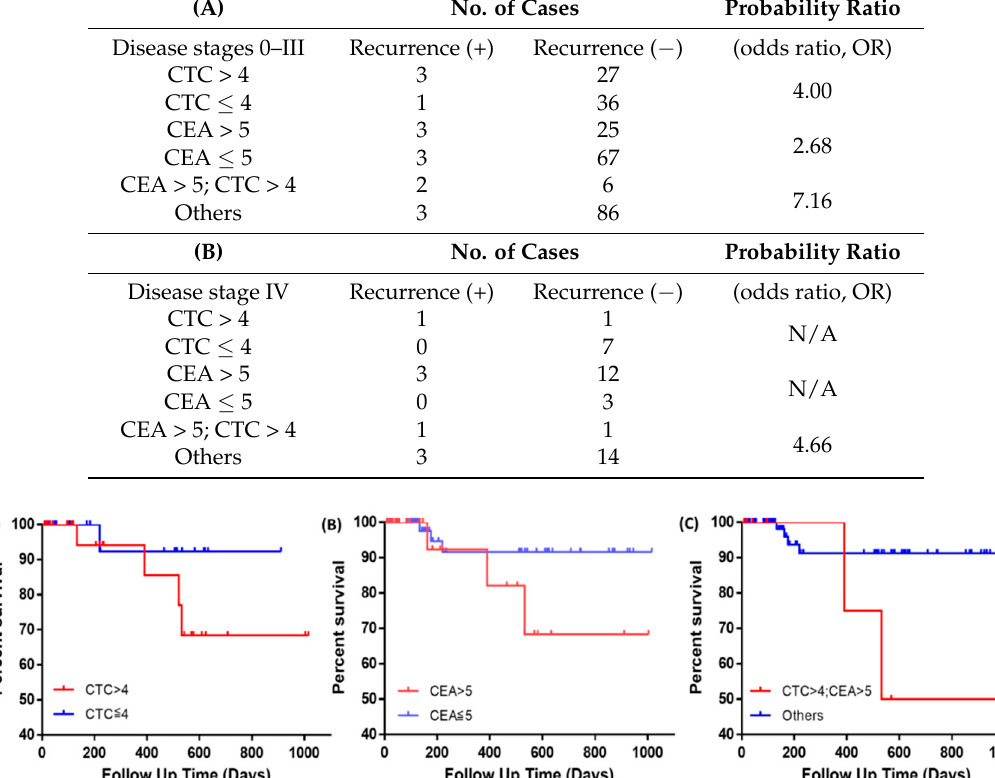
Figure 5. Kaplan–Meier survival curves of progression-free survival in patients with non-metastatic diseases, stratified with CTC and CEA. ( A ) Red line: CTC > 4; blue line: CTC ≤ 4; p = 0.242; ( B ) red diseases, stratified with CTC and CEA. ( A ) Red line: CTC >4; blue line: CTC ≤ 4; p = 0.242; ( B ) red line: CEA >5 ng/mL; blue line: CEA ≤ 5 ng/mL, p = 0.176; ( C ) red line: both CTC >4 and CEA >5 ng/mL; blue